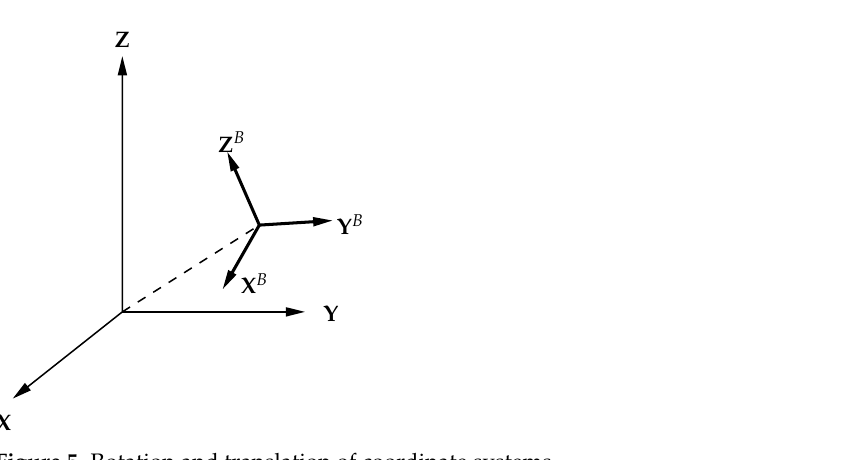
Figure 5. Rotation and translation of coordinate